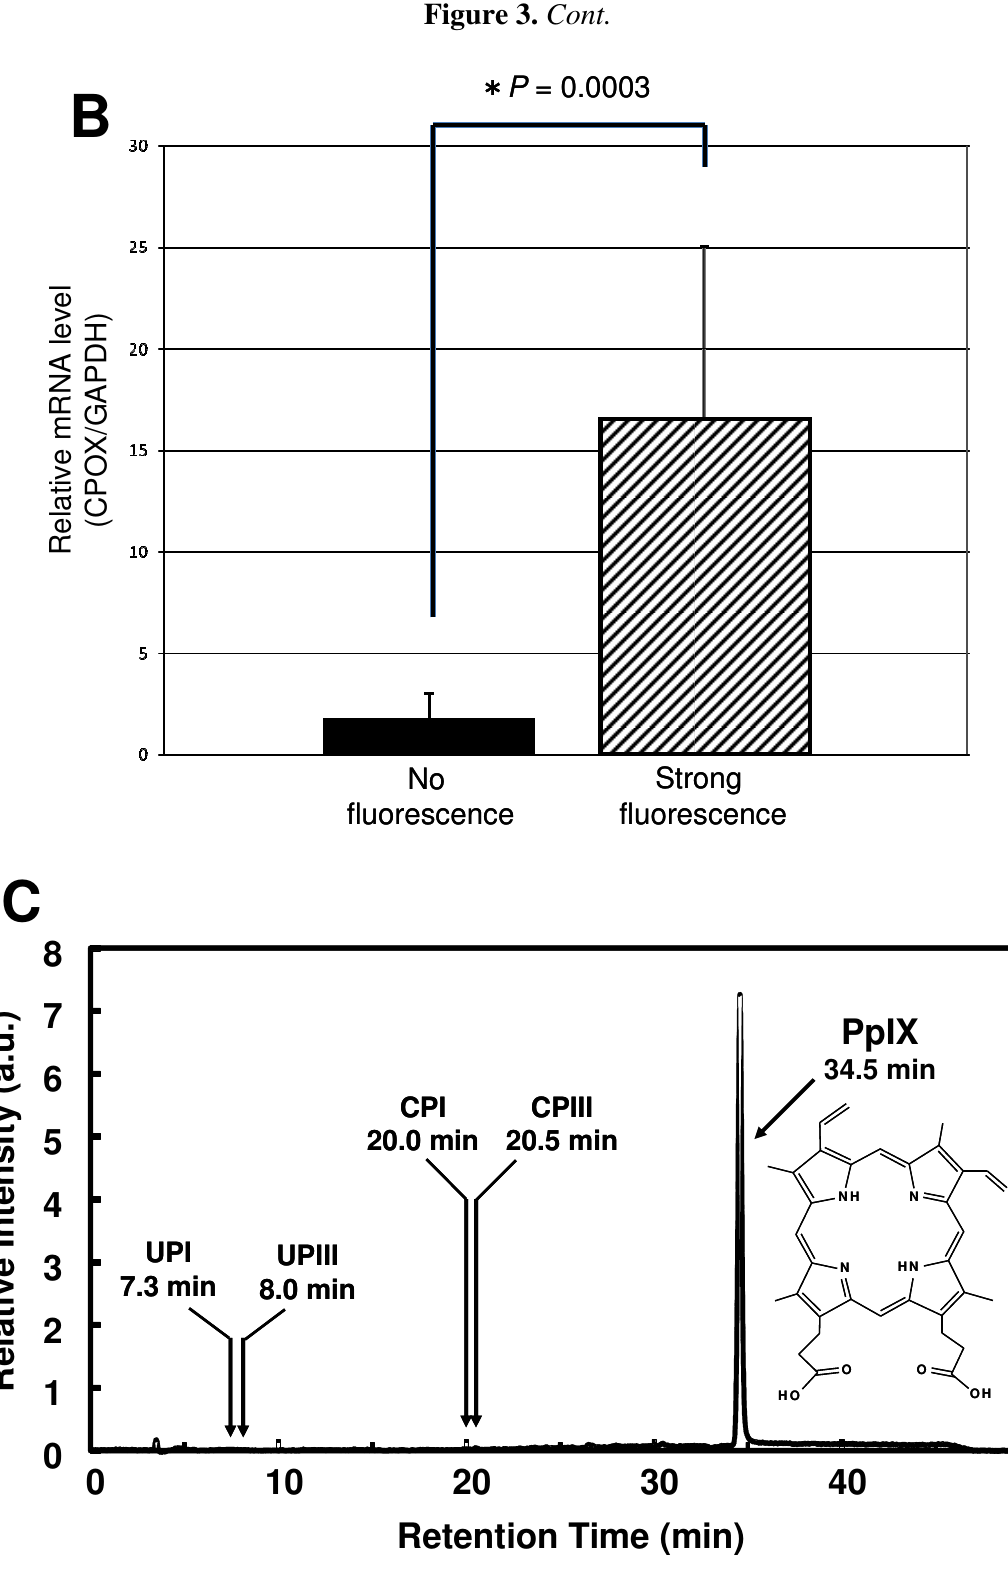
Figure 3. Cont. ＊ P = 0.0003 ＊ P =